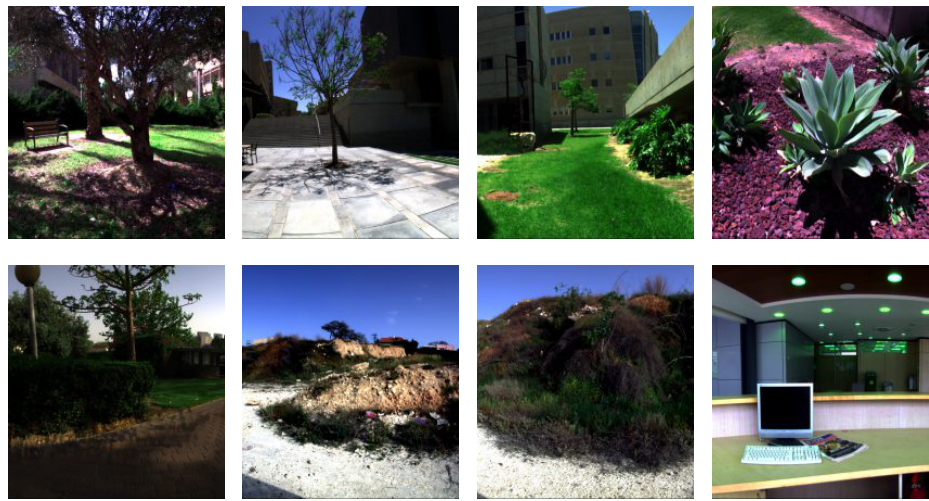
Figure 10. This is the ICVL